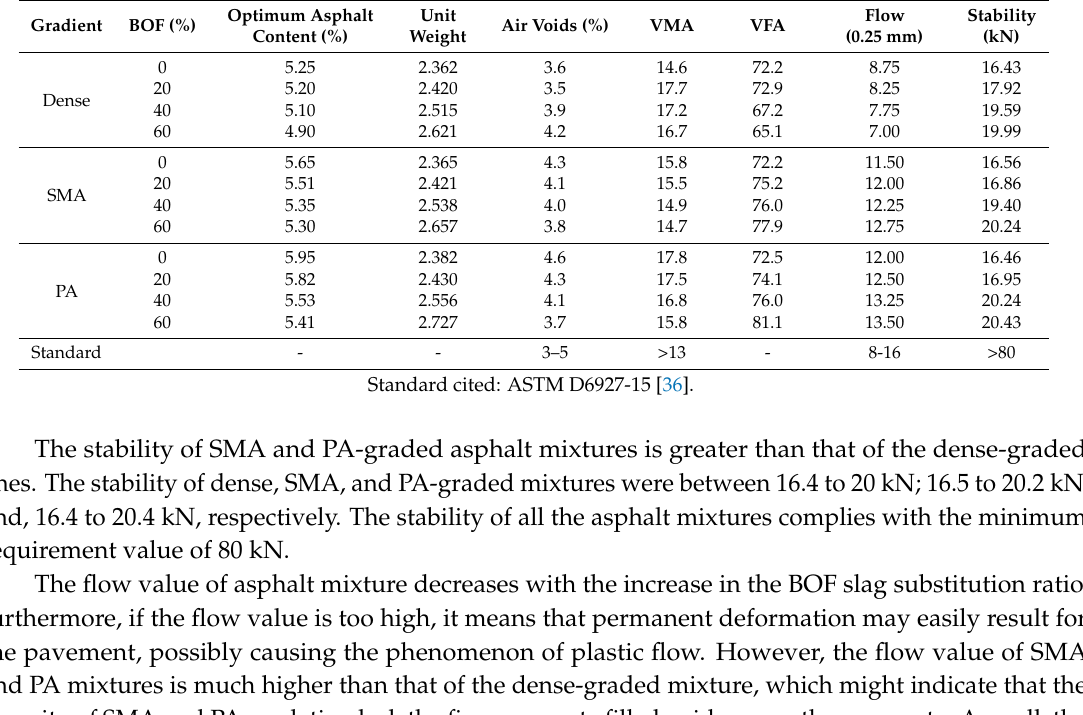
Table 6. Marshall testing results of BOF